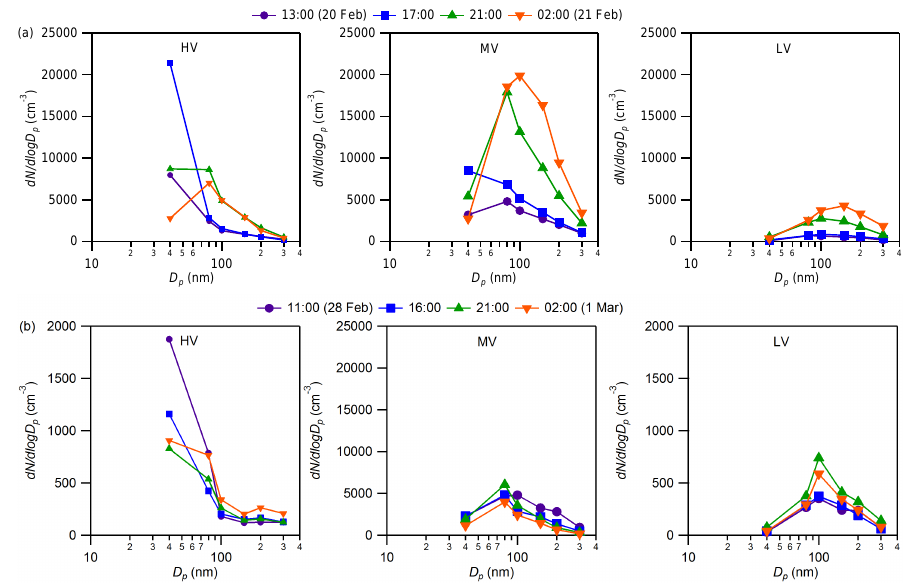
Figure 11. Particle number size distribution of (columns from left to right) HV, MV and LV particles (a) during a new particle formation event at 13:00, 17:00, 21:00 on 20 February and 02:00 on 21 February 2014 and (b) during non-event days at 11:00, 16:00, 21:00 on 28 February and 02:00 on 1 March 2014.